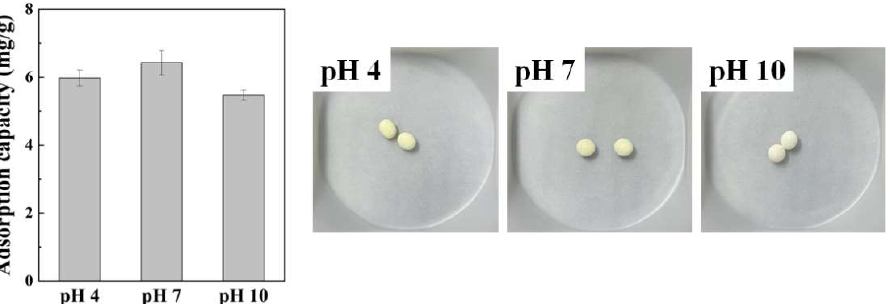
Figure 8. Iodide adsorption capacity as a function of initial pH of iodide solution ( left ) and photographs of Alg–BO after iodide adsorption ( right ). Initial iodide concentration = 20 mg/L; initial pH 4, 7, and 10; adsorbent concentration = 1 g/L; contact time = 24 h.